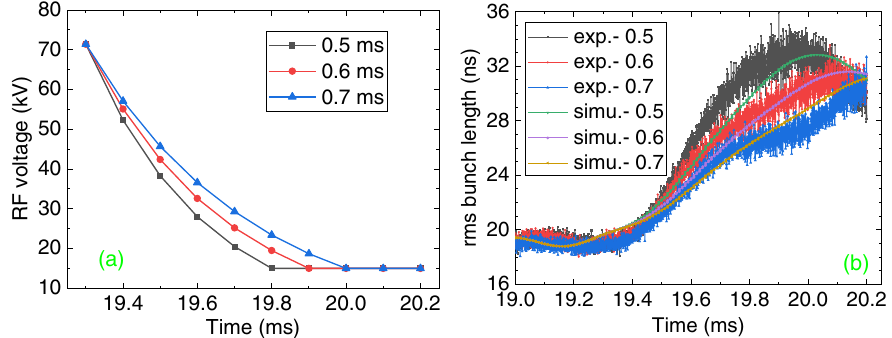
FIG. 10. (a) The rf voltage curves for different decay times: 0.5, 0.6, and 0.7 ms. (b) The evolutions of the bunch length during the bunch stretching process from both the experiments and simulations.